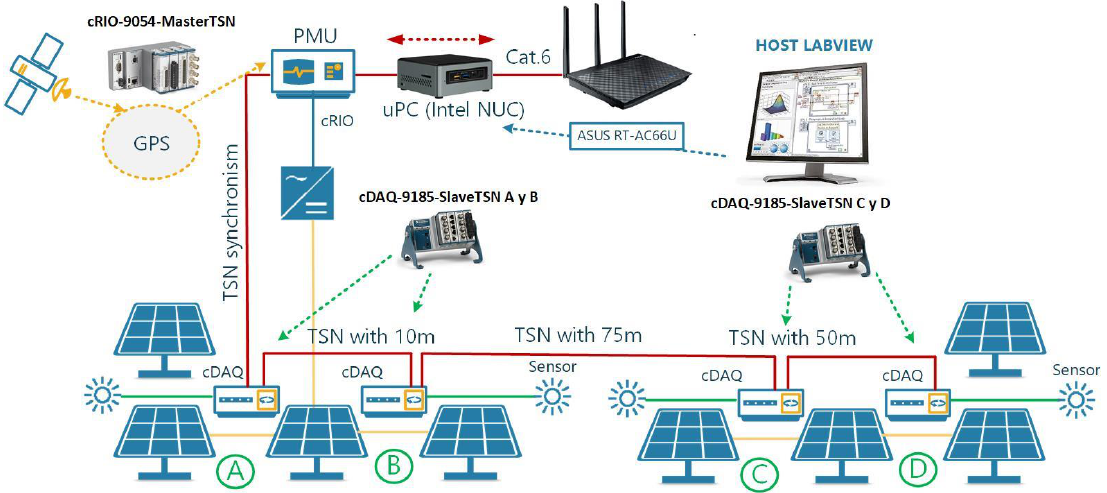
Figure 4. Configuration (2) for tests with one cRIO-9054 and four cDAQ-9185s.